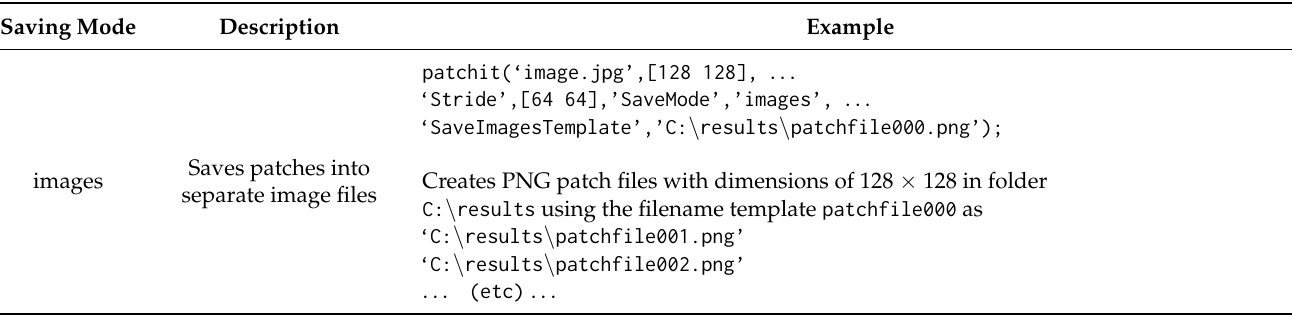
Table 3. Patch-saving options.